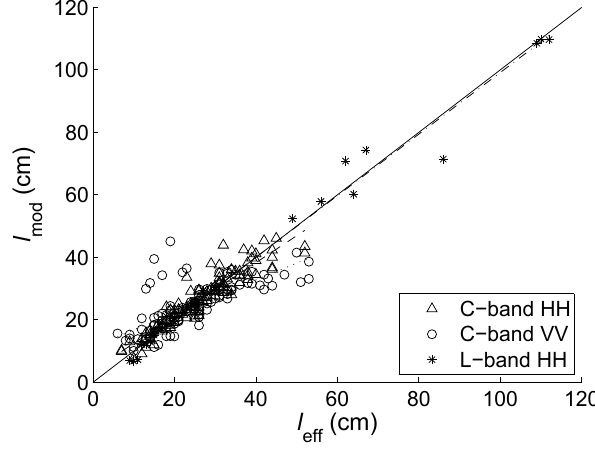
Fig. 11. Modelled correlation length ( l mod ) versus effective corre- lation length ( l eff ) for the different SAR configurations used.